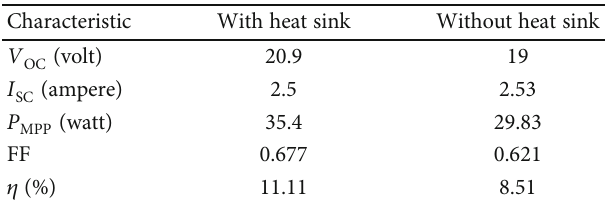
Table 2: Electrical performance of a PV panel with and without aluminum heat sinks under 1000W/m 2